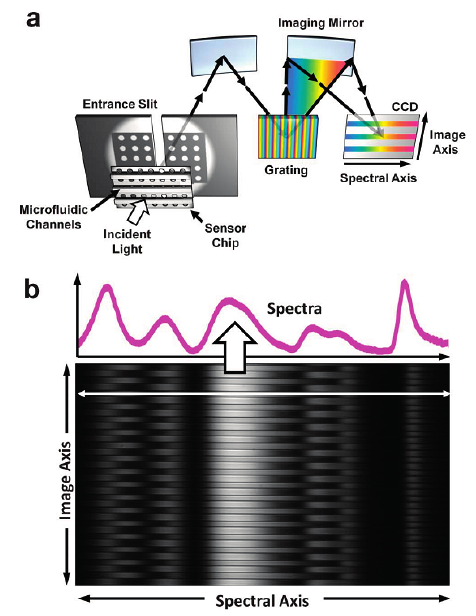
Figure 5. ( a ) Schematic of SPR imaging setup using nanohole arrays and parallel microfluidic channels. ( b ) Sample date measured by a captured CCD image. Spectral signal along a horizontal line on the sensing area shows the transmission spectrum for a single microfluidic channel (Reproduced with permission from